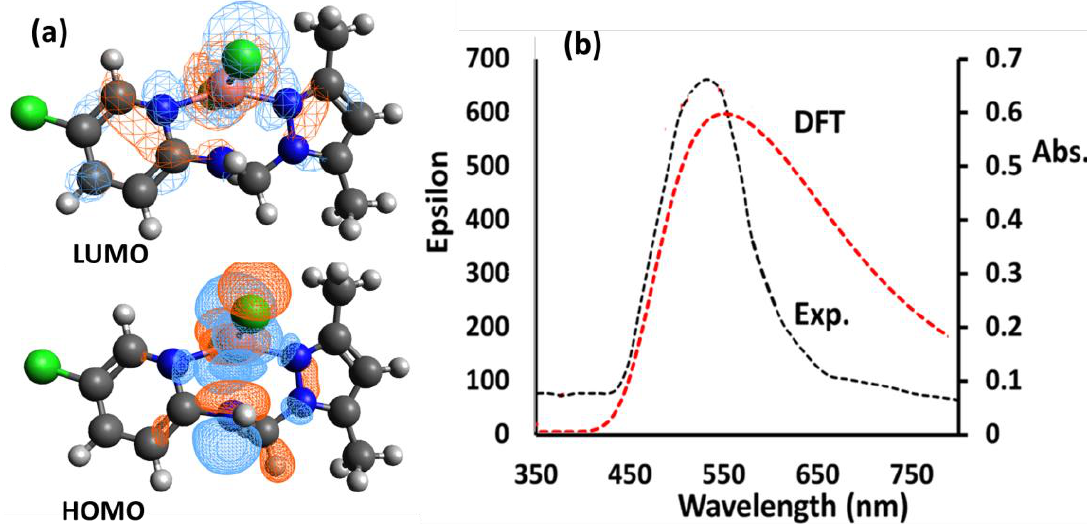
Figure 5. ( a ) HOMO/LUMO, and ( b ) visible/TD-DFT of the Co(II)/pyrazole complex in MeOH. Table 2. Main TD-DFT bands with their parameters.